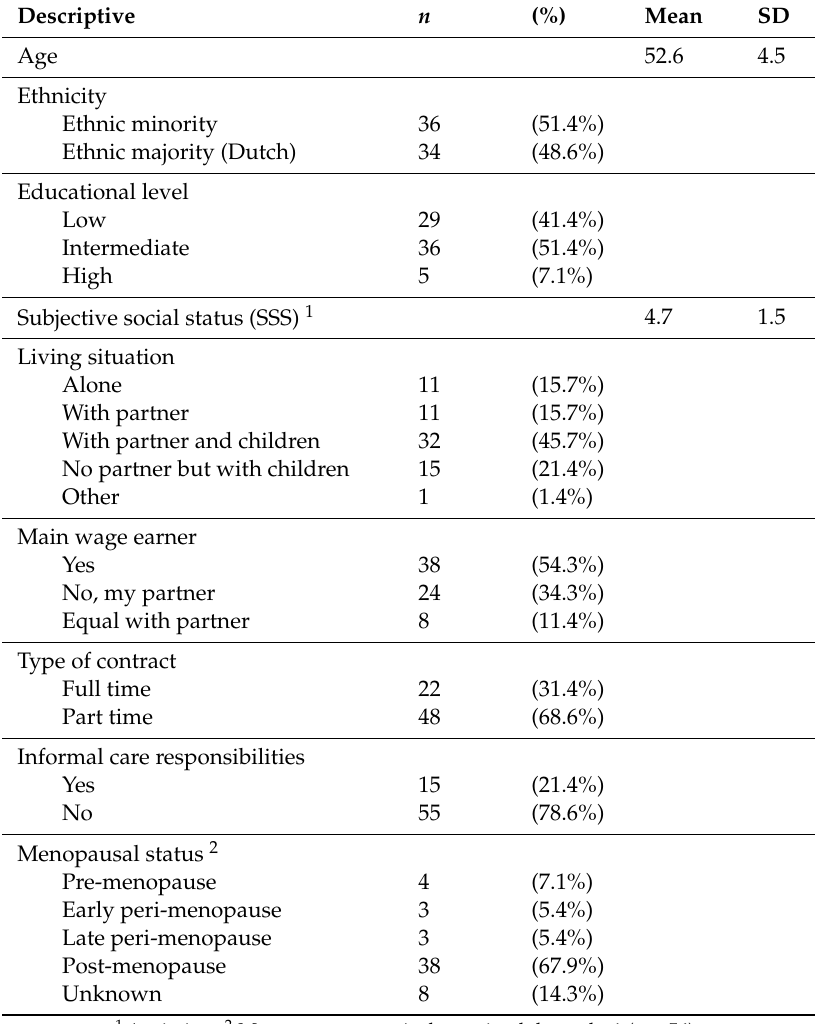
Table 2. Participant characteristics ( n = 70, including